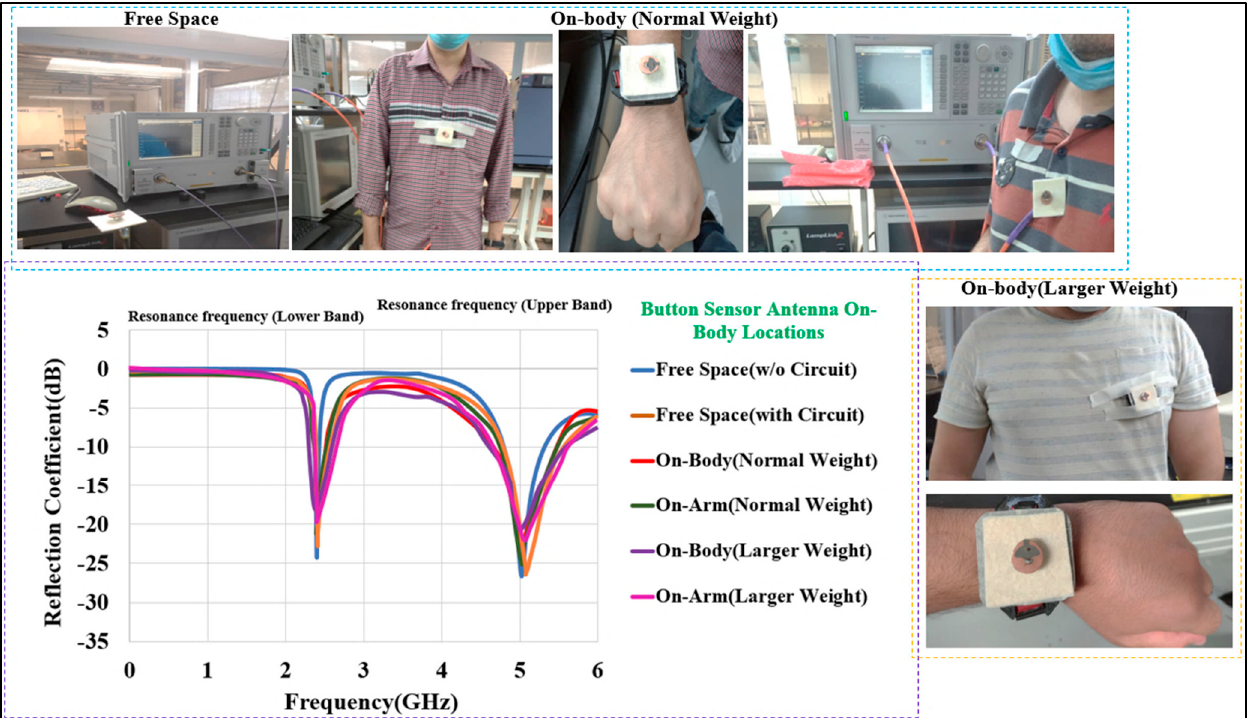
Figure 19. Measured S 11 of the BSA in free space and on-body (chest and small and large size arm diameter of 50 mm and 100 mm, respectively).